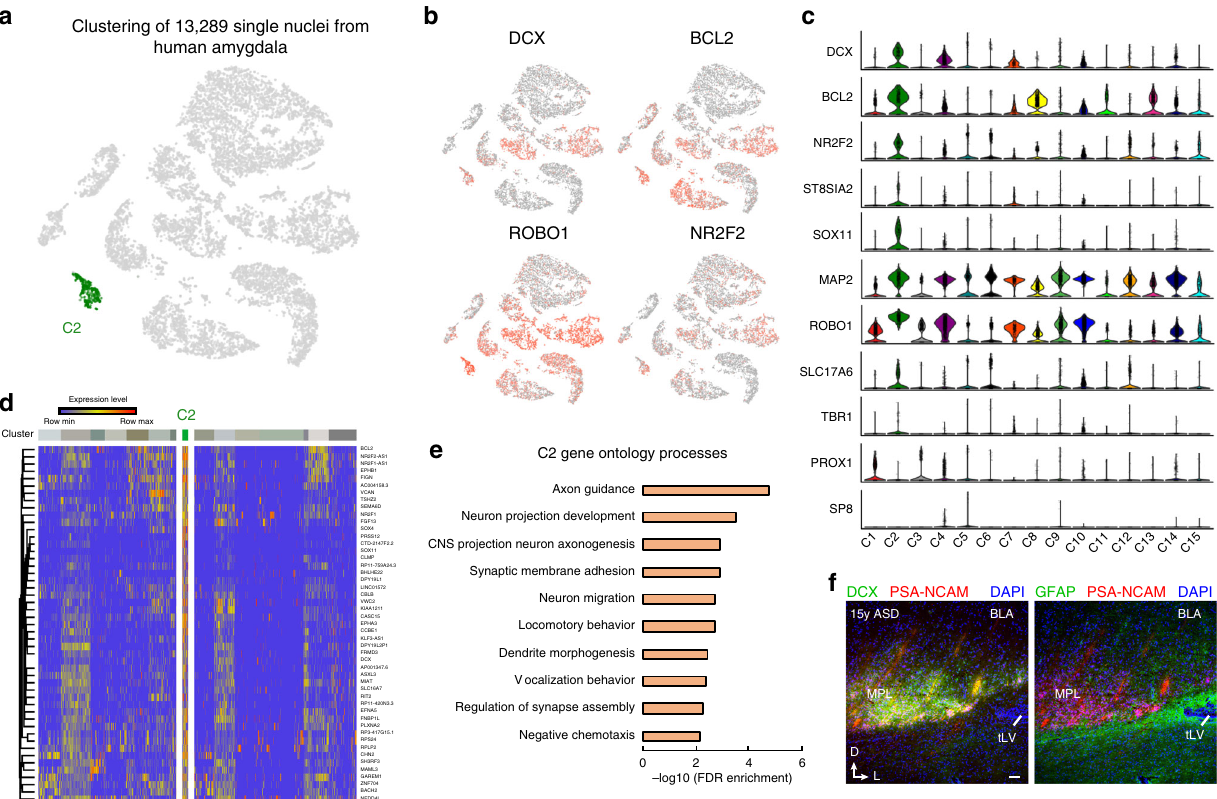
Fig. 8 Single-nuclei RNA-seq analysis of immature PL cells in the human amygdala. a Identi fi cation of immature PL neurons based on unbiased clustering (C2). b , c Expression of markers of immature PL neurons across cell types in the human amygdala. t-SNE plots are colored based on log-transformed and normalized unique molecular identi fi ers (UMIs). Violin plots are color-coded based on the cluster identity. d Unbiased gene signature of immature PL neurons. Expression level corresponds to log-transformed normalized UMIs. e Gene Ontology terms enriched for markers genes of immature PL neurons. f Example of regions analyzed in the single nuclei RNA-seq dataset: 15-year-old ASD amygdala containing DCX + PSA-NCAM + regions wrapped with GFAP + processes, corresponding to the MPL. Scale bar: 100 µ m ( f